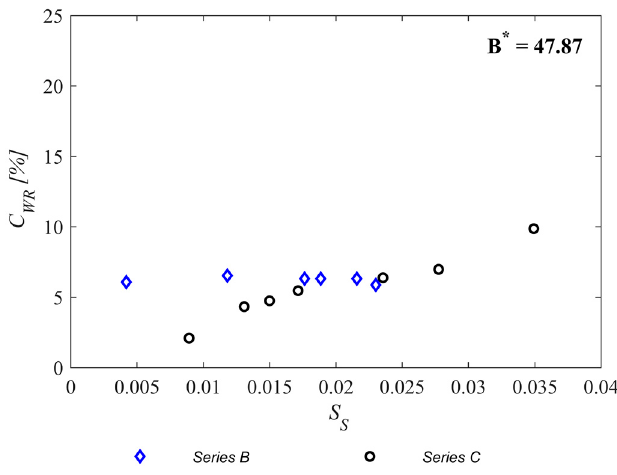
Figure 9. Variation of the capture width ratio ( C WR ) with the significant wave steepness ( S S ) for irregular waves (Series B and C); and for the intermediate damping coefficient (prototype data).